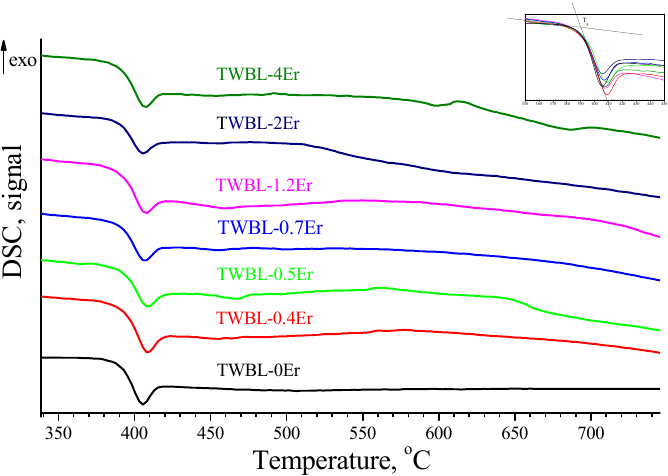
Figure 2. DSC-thermograms of TeO 2 -WO 3 -Bi 2 O 3 -(4-x)La 2 O 3 -xEr 2 O 3 glasses, x = 0; 0.4; 0.5; 0.7; 1.2; 2; 4 mol% (heating rate 10 K/min).